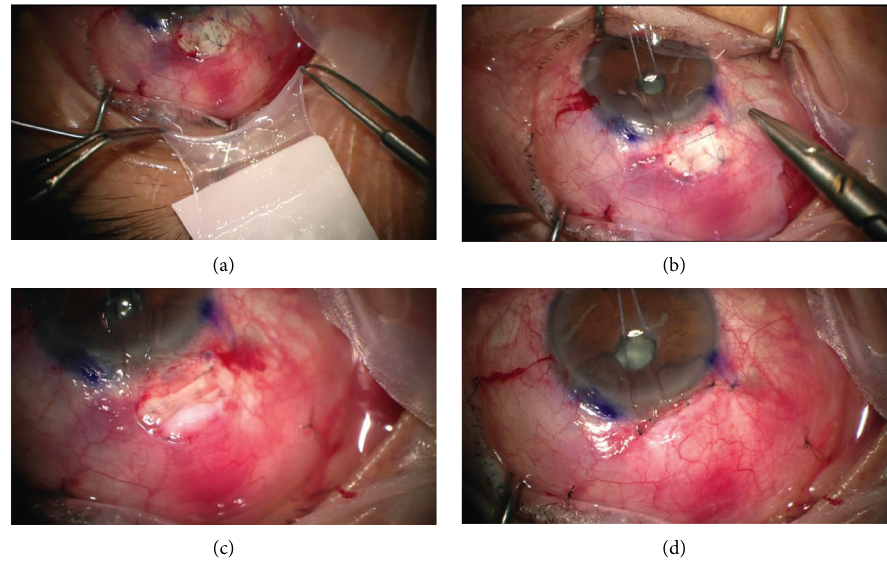
Figure 1: Surgical procedure of fornix-based trabeculectomy with amniotic membrane transplantation. (a) Amniotic membrane was peeled from nitrocellulose membrane. (b) Rectangular amniotic membrane was placed over scleral flap with the stromal side up. The limbal side of the amniotic membrane was secured to both sides of the scleral flap margin with two micro-point 10-0 nylon vascular needles. (c) The amniotic membrane was placed with stromal side up underneath tenon’s capsule. (d) The conjunctiva and tenon’s capsule were closed with interrupted micro-point 10-0 nylon vascular Table 1: Demographics and clinical characteristics of patients in both groups.